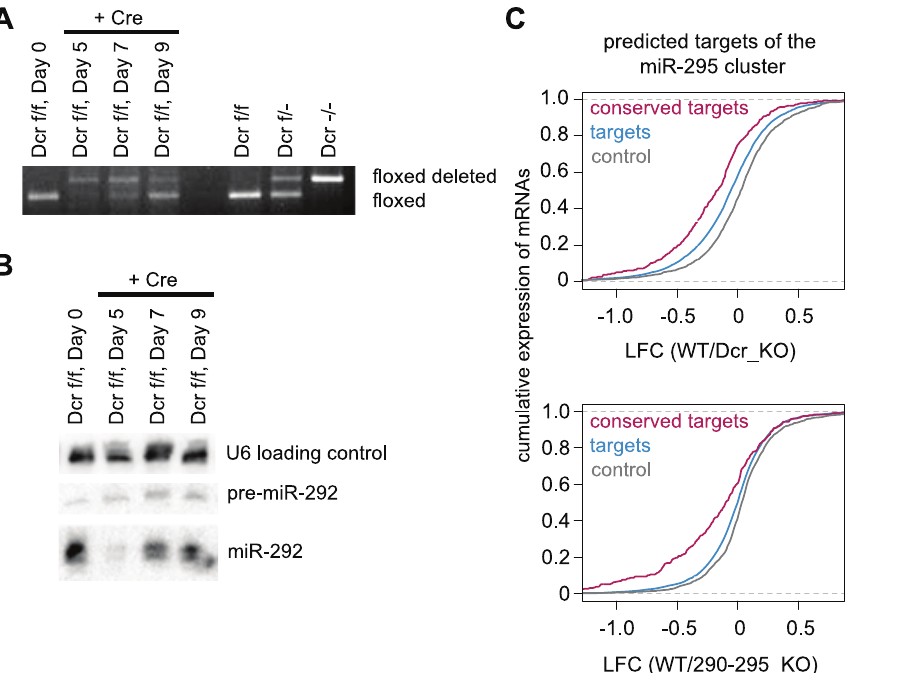
Figure 1. Acute Dicer deletion and specific mir-295 cluster deletion show global target derepression signatures. A. PCR for confirmation of Dicer loss on acute deletion. Dicer floxed and floxed-deleted bands were amplified over a nine day time course to determine the point of maximal enrichment for Dicer null cells. B. Northern blot for mature miRNAs following Dicer deletion. A DNA probe for the abundant miR-292 was assessed at 5, 7, and 9 days following Dicer deletion, with a probe for U6 to control for loading. C. Cumulative distribution functions (cdfs) of log 2 fold change (LFC) in mRNA expression between Dcr WT and Dcr KO ES cells (top panel) and 295 WT and 295 KO ES cells (bottom panel) are plotted. Plots include conserved targets (red line), all predicted miR-295 targets (blue line), and control mRNAs (grey line). targets include , 3000 predicted TargetScan targets of the miR-295 cluster. Conserved targets contains the , 300 genes in the top 10% of targets ranked by TargetScan 5.1 branch length scores. The control mRNA set was selected to match the predicted targets in expression, 3’ UTR length and composition. Targets are derepressed in both Dcr KO as well as 295 KO mESCs ( p # 2.2e 2 16 and p =9.7e 2 9 by rank sum test, respectively). Similarly, conserved targets are derepressed in both Dcr KO as well as 295 KO mESCs ( p # 2.2e 2 16 and p =3.1e 2 14 by rank sum test,